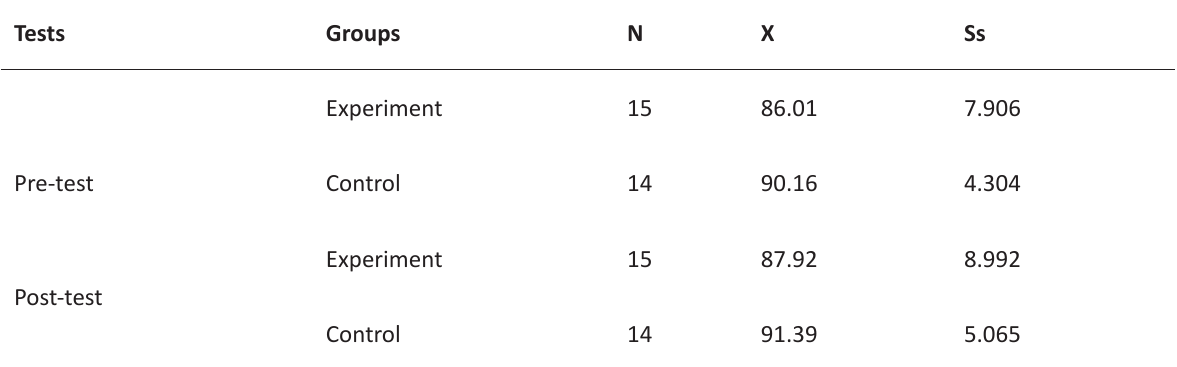
Table 3. Comparison of the Dynamic Balance of Pre and Post Test Results of